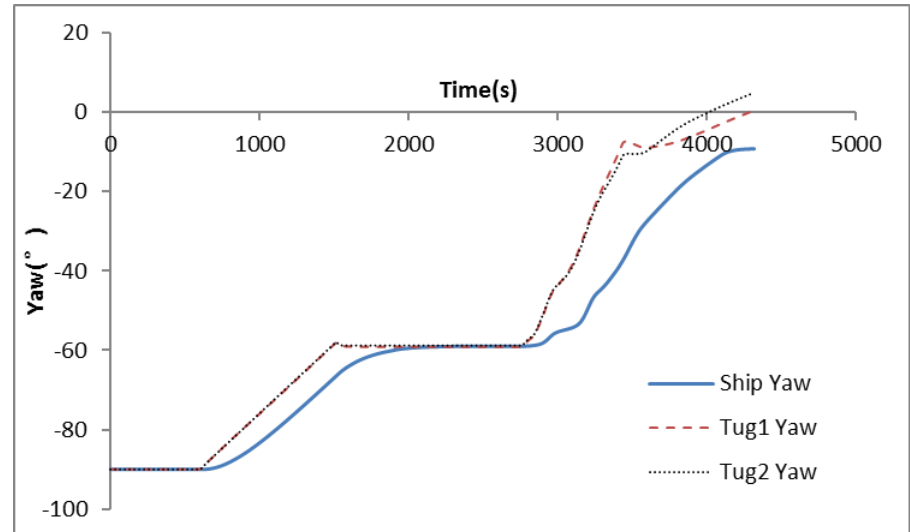
Figure 20. The change of rope length during the towing process.